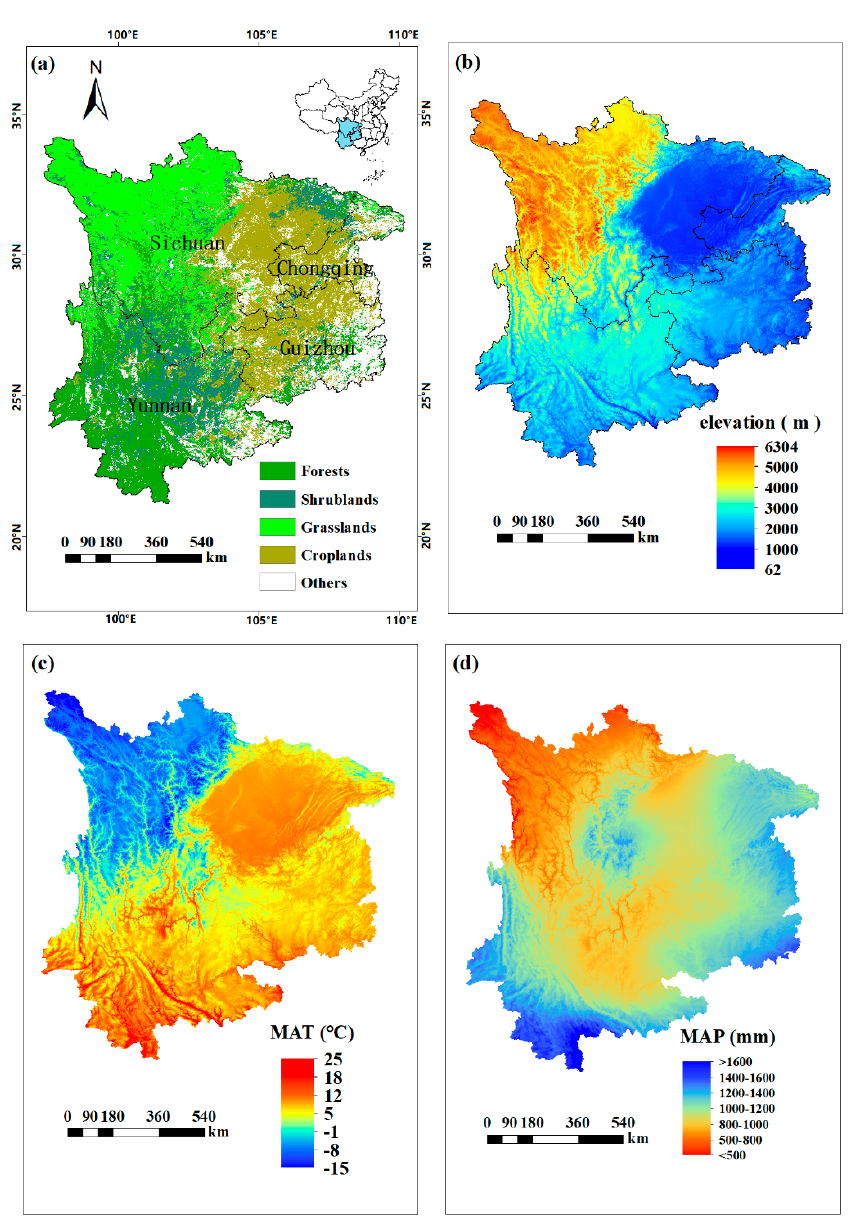
Figure 1. The land cover, elevation, and climate of Southwest China: ( a ) land cover types; ( b ) elevation; ( c ) mean annual temperature (MAT); ( d ) mean annual precipitation (MAP).